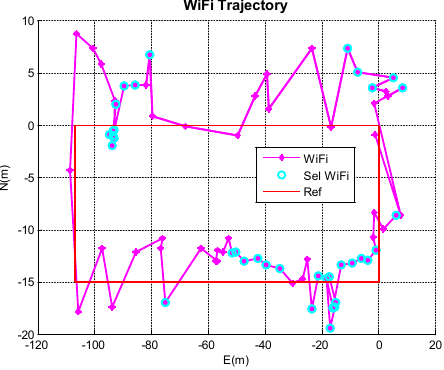
Figure 13. Navigation results of PDR, the proposed MEMS solution, and WiFi/MEMS integration (Trajectory III: Pedestrian 3, Smartphone C). ( a ) Trajectories; ( b ) Cumulative error percentages.